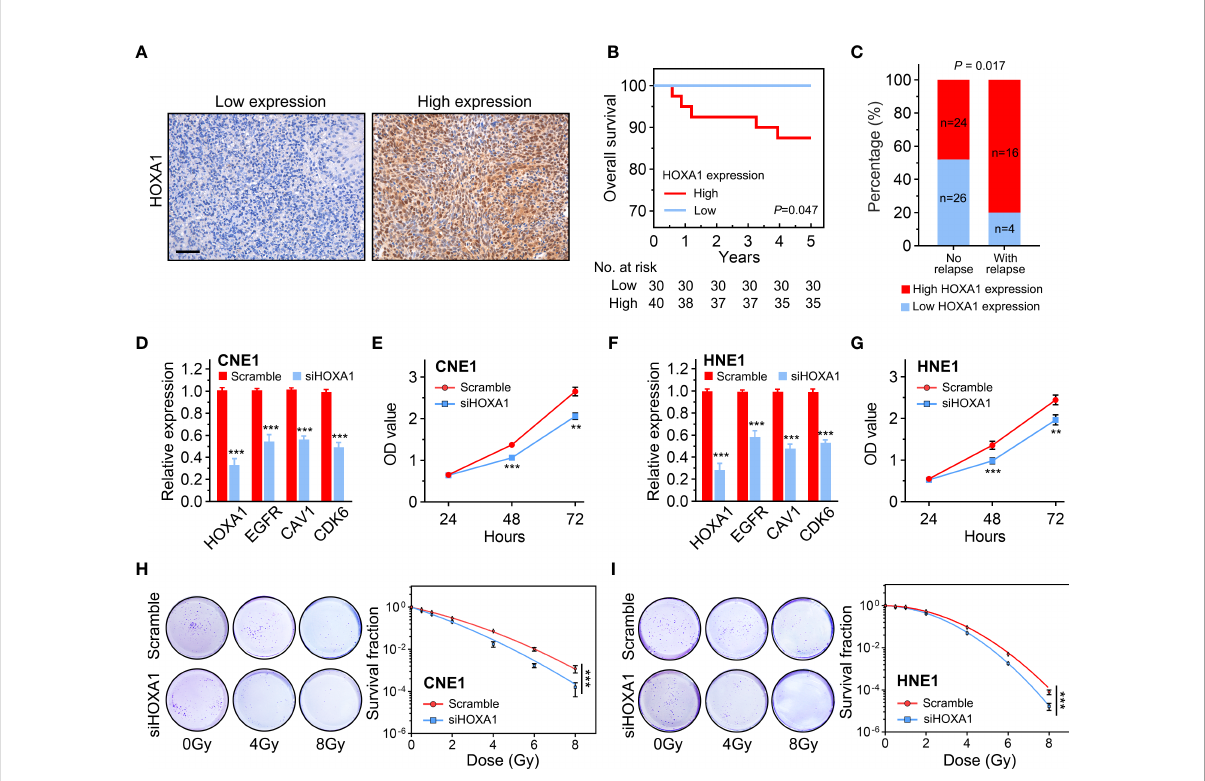
FIGURE 5 HOXA1 enhanced the radioresistance of NPC cells. (A) Representative immunohistochemistry images showing low and high HOXA1 expression in NPC tissues. Scale bars, 50 m m. (B) Overall survival curves of NPC patients. (C) Cumulative bar chart showing that high HOXA1 expression was correlated with high risk of local relapse in NPC patients. (D) knockdown of HOXA1 expression downregulated EGFR, CAV1 and CDK6 expression in CNE1 cells. (E) knockdown of HOXA1 expression reduced the proliferation of CNE1 cells. (F) knockdown of HOXA1 expression downregulated EGFR, CAV1 and CDK6 expression in HNE1 cells. (G) knockdown of HOXA1 expression reduced the proliferation of HNE1 cells. (H, I) Dose-survival curves showing that knockdown of HOXA1 expression enhanced the radiosensitivity of CNE1 and HNE1 NPC cells. ** P < 0.01; *** P <